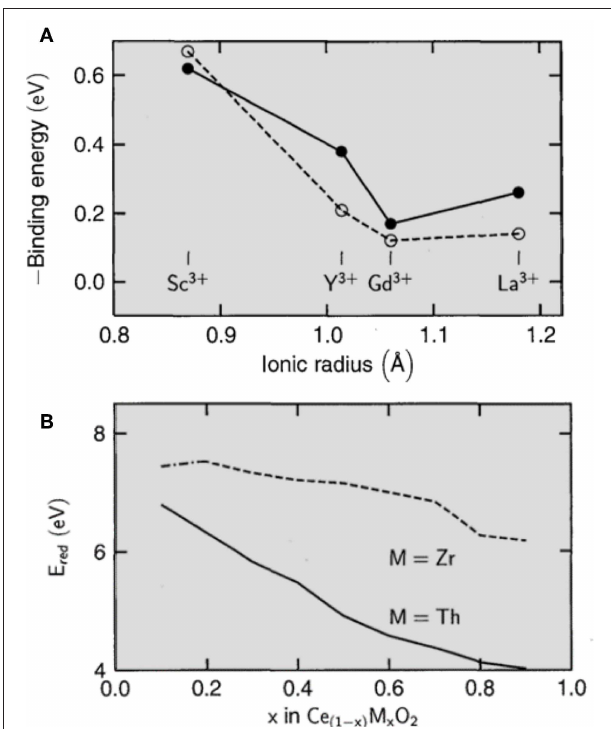
FIGURE 7 | (A) Ce 4 + /Ce 3 + reduction energy (calculated → solid line; experimental → dashed line) as a function of dopant composition and (B) Ce 4 + /Ce 3 + reduction energy (calculated → solid line; experimental → dashed line) as a function of dopant composition (adapted from Trovarelli and Fornasiero, 2013